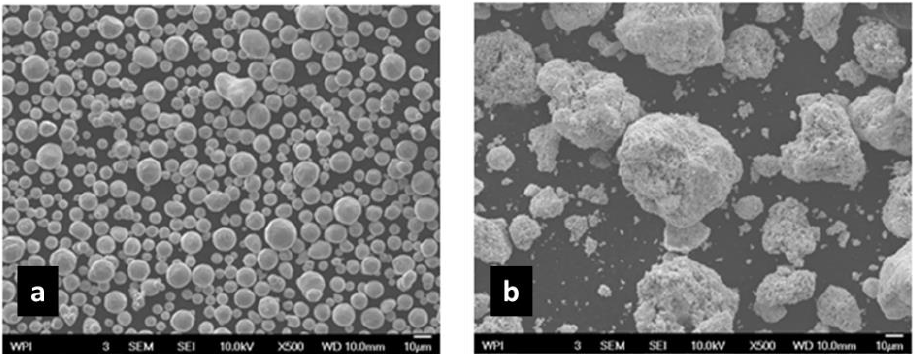
Figure 2. Conventional ( a ) and nanoscale ( b ) copper powders.